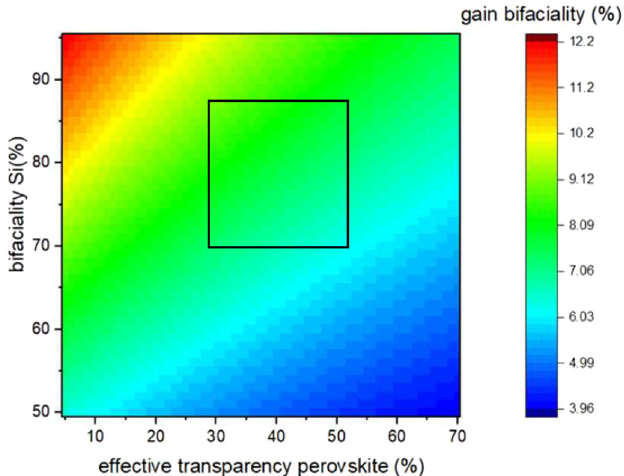
Fig. 1. Additional power (in percentages) due to the bifaciality of the bottom cell in comparison to the same tandem module applied monofacially assuming rear injection of 135 W/m 2 with STC front, and equal single junction device ef fi ciencies at STC. The transparency of the perovskite is bottom cell ef fi ciency/single junction ef fi ciency ratio. The bifaciality of the silicon cell is for the silicon cell as component. This graph provides a visual representation of the justi fi cation of bifacial tandems. Note the square in the graph denotes common distribution of bifaciality and transmission.